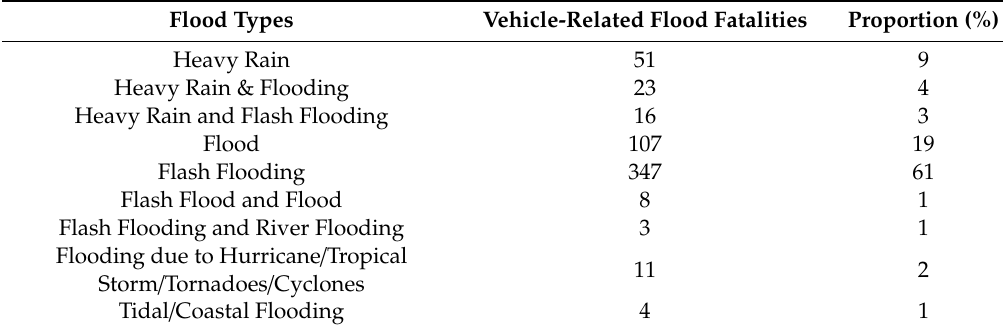
Table 2. Vehicle-related flood fatalities by flood types in Texas, 1959–2019.